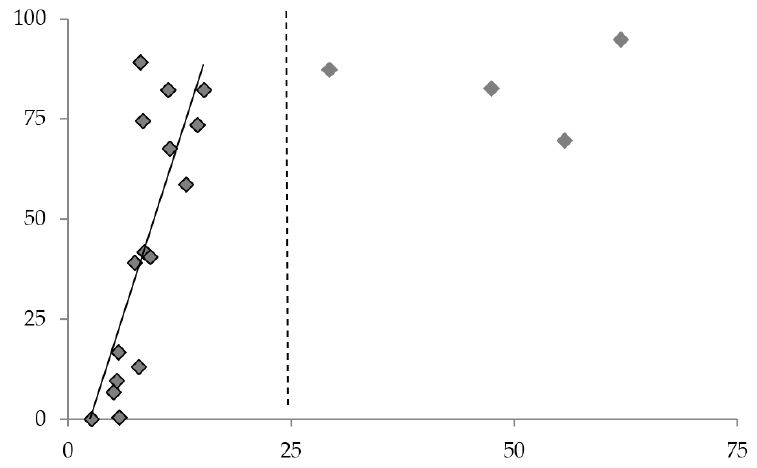
Figure 8. Percent I total gain vs. percent ILSS loss for all exposures. Dashed line—exposures causing ILSS loss higher than this line were detectable via UT C ‐ scan.